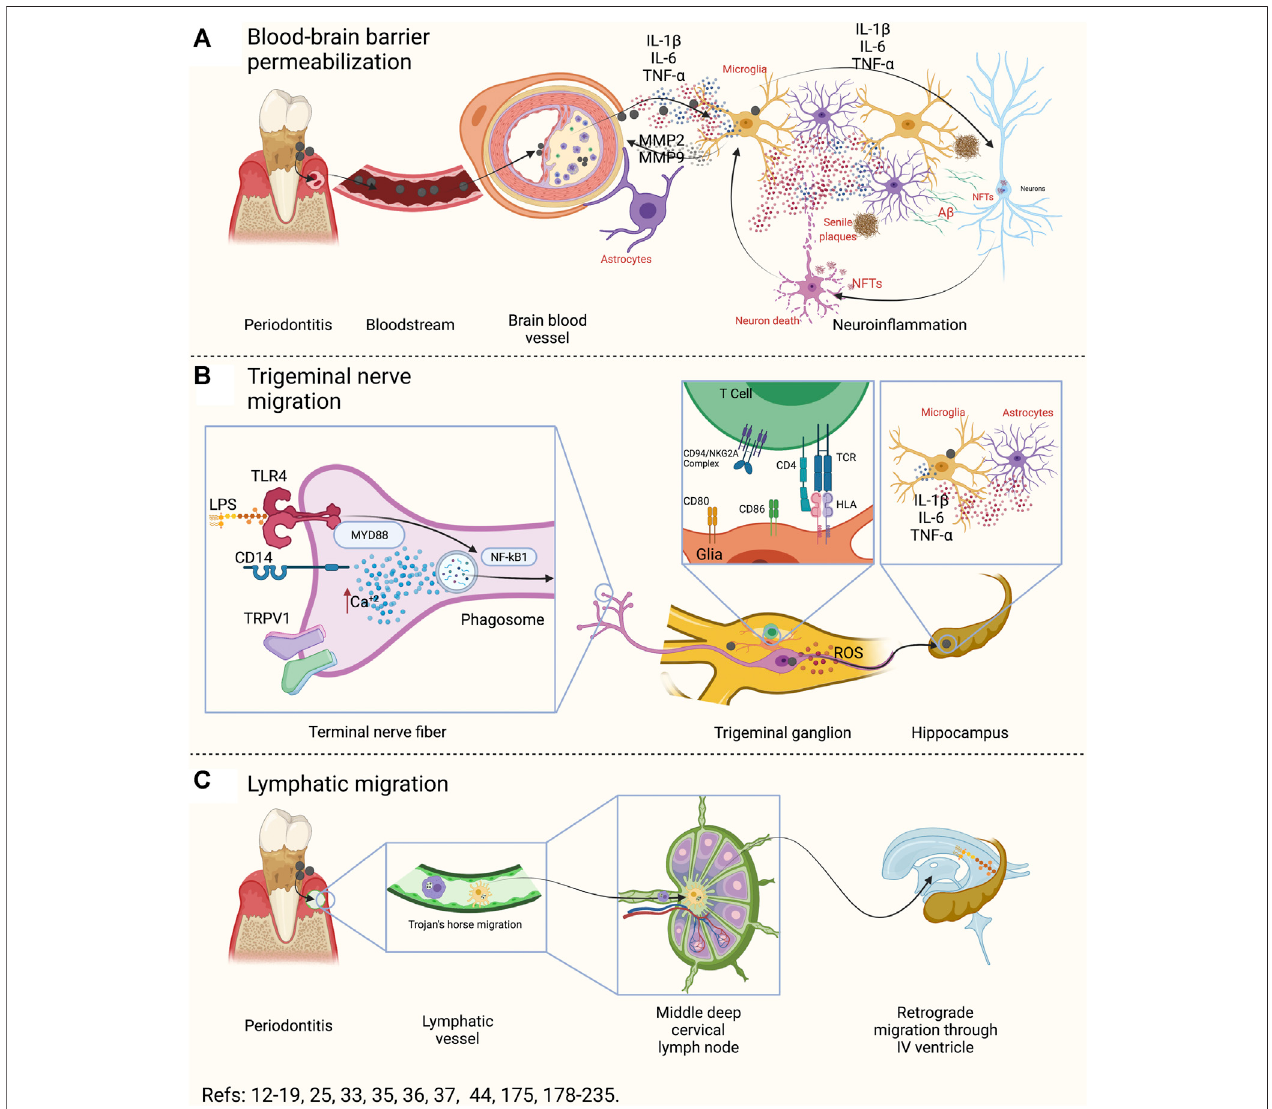
FIGURE 4 | Oral-Brain axis components. (A) During periodontitis, possible transient bacteremia could induce atherogenesis at the brain level. Macrophages and endothelial cells associated with atheroma plaque can produce pro-in fl ammatory mediators, which spread to the brain. There, it produces functional changes both in the astrocyteoftheneurovascularunitandinthemicroglia.Bothcells,inresponsetolocalin fl ammation,willproduceIL-1 β ,IL-6,IL-17,andTNF- α and,togetherwithMMP2and MMP9,willproduceanexacerbationofin fl ammationanddegradationoftheproteinsoftheneurovascularunit.Inthisway,abreakoutoftheBBBwilloccurs.Then,the in fl ammation induced by microglia and reactive astrocytes will affect neuronal function, generating the necessary stimuli for the production of amyloid β and hyperphosphorylationofthe Tau protein. Inthisway,the BBB breakdown mayproducesenileplaques,NFTs, and neuronaldeath. (B) The fi bersofthe trigeminalnervethat innervate the periodontal tissues have various surface receptors that can recognize LPS, capsularpolysaccharides, fi mbria, among other virulence factors. The activation of thesereceptors(TLRs,CDs,andTRPV1)caninducetheactivationofNF- κ B,theformationofthephagosomeortheincreaseofintracellularCa+2.Inresponse,theneuronwill respond by producing IL-1 β , IL-6, and TNF- α in the trigeminal ganglion. Furthermore, in the trigeminal ganglion there are glial cells that are capable of recognizing bacteria, engul fi ng, processing, and presenting them to the CD4 + T lymphocytes in the trigeminal ganglion. Pathogenic bacteria that have the ability to inhibit phage-lysosome formation can remain alive within the phagosome and, through vesicular traf fi cking, can move along the axon or dendrites of the neuron. Thus, this could be a possible bacterialmigration pathway. Furthermore,neuronsthatrecognizepathogenicbacteriacould secretepro-in fl ammatory cytokinesinthetrigeminalpontinenucleusorinother areas of the brain, and generate activation in microglia and astrocytes. (C) The lymphatic pathway is made up of antigen-presenting cells that recognize, incorporate, and process pathogenic bacteria, and migrate to the regional lymph node to present the antigen. In the regional lymph node they can present CD4 + T lymphocytes, which depending on the context, will differentiate into the different effector phenotypes. Certain pathogenic bacteria have the ability to inhibit phage-lysosome formation and thus surviveandmigrateutilizinghostcellmigrationmechanisms.Inthisway,onceinthelymphnode,thephagocytescouldmigratetoanotherlymphnodeor,thebacteriacould migrate through the lymphatic vessels to another lymphatic site. In particular, the III and IV cerebral ventricle drains, as do the submandibular or parotid lymph nodes, tothe deep mid-cervical cervical. Therefore, the oral cavity and the brain would be lymphatically connected. IL: interleukin, TNF: tumor necrosis factor, MMP: matrix metalloproteinases, BBB: blood-brain barrier, LPS: lipopolysaccharide, TLRs: toll-like receptors, CDs: cluster of differentiation, TRPV1: transient receptor potential cation channel V1, NF- κ B: nuclear factor κ B, NFTs: neuro fi brillary tangles, TCR: T-cell receptor, HLA: human-leukocyte antigens, ROS: reactive oxygen species.